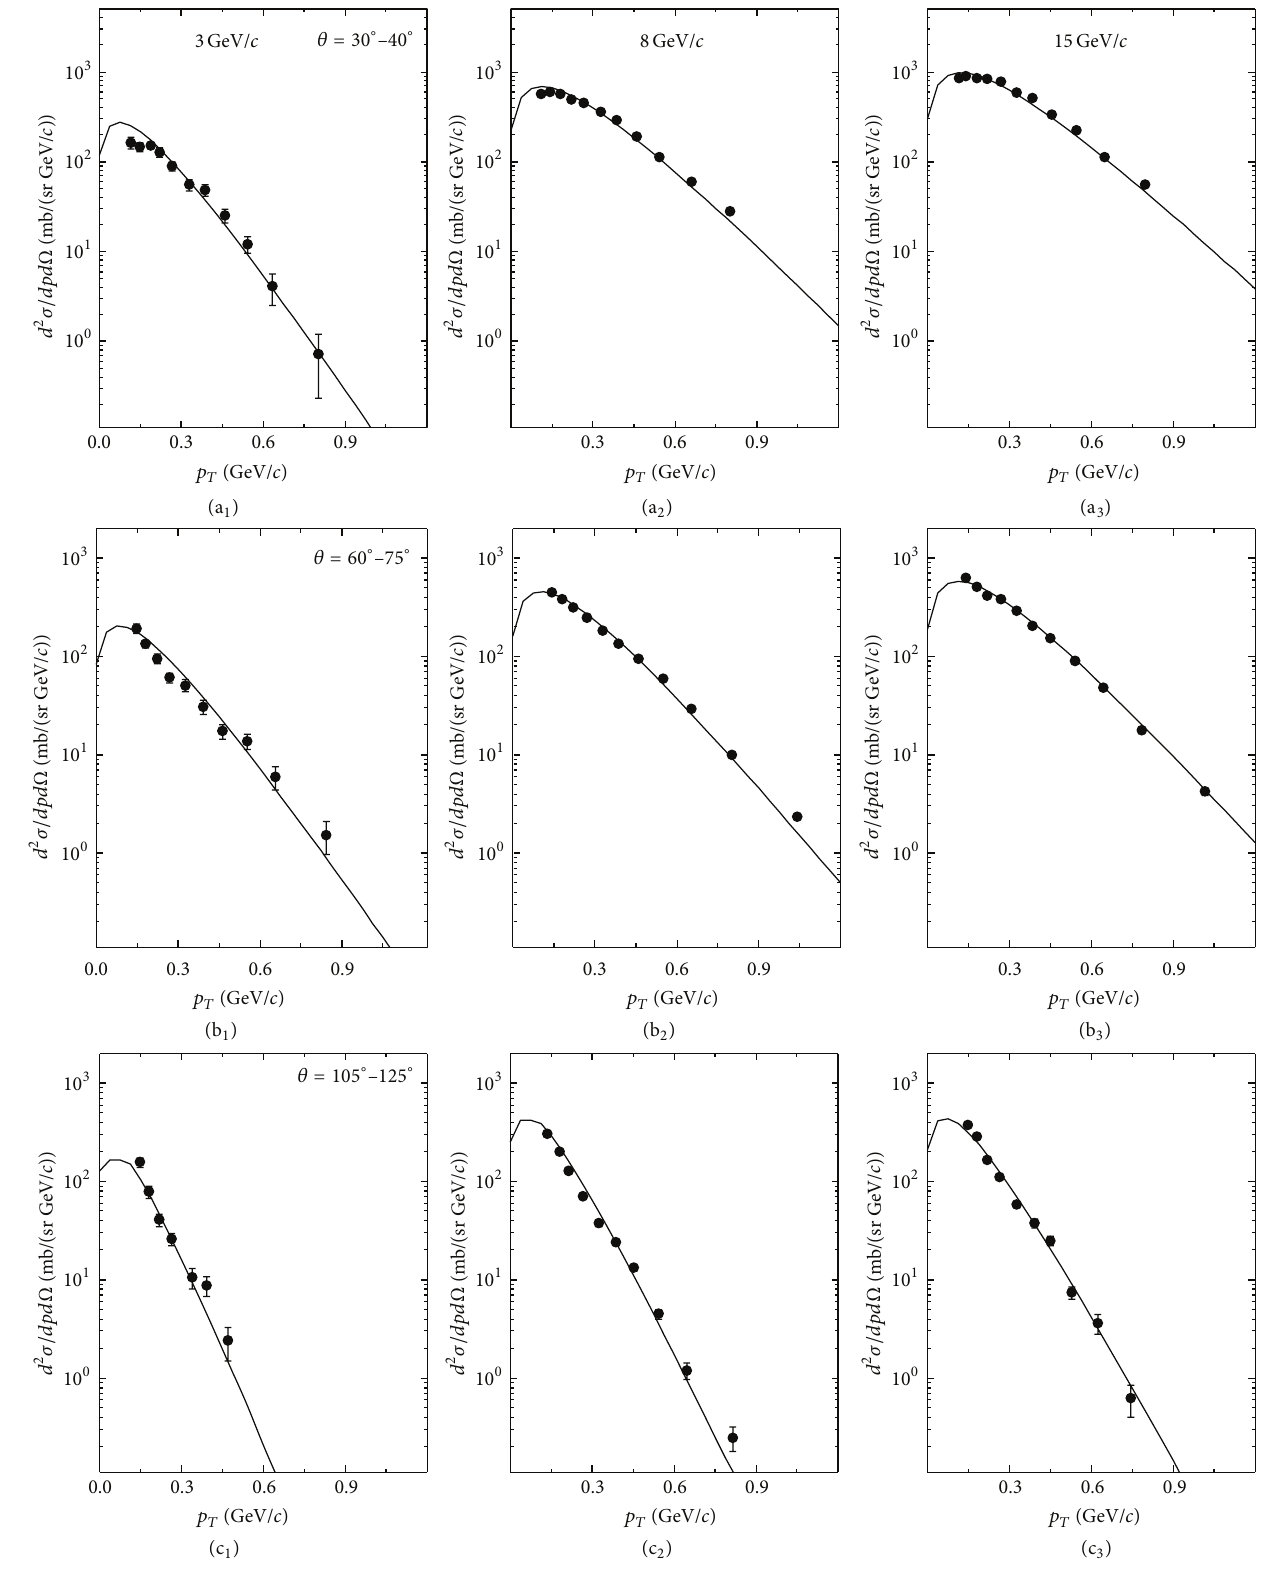
Figure 5: The same as Figure 4, but for 𝜋 −